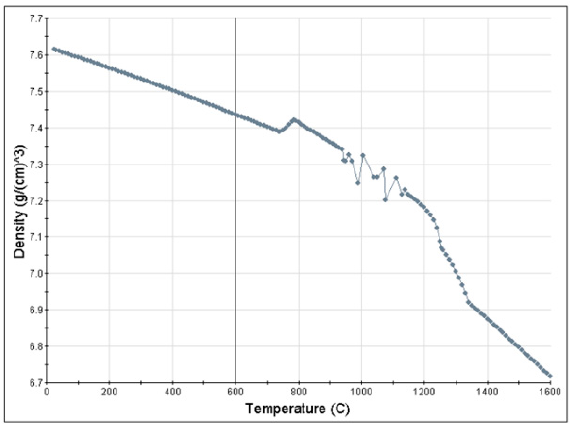
Figure 3. The density curve of the Fe-12Cr-2.08C alloy vs. temperature.